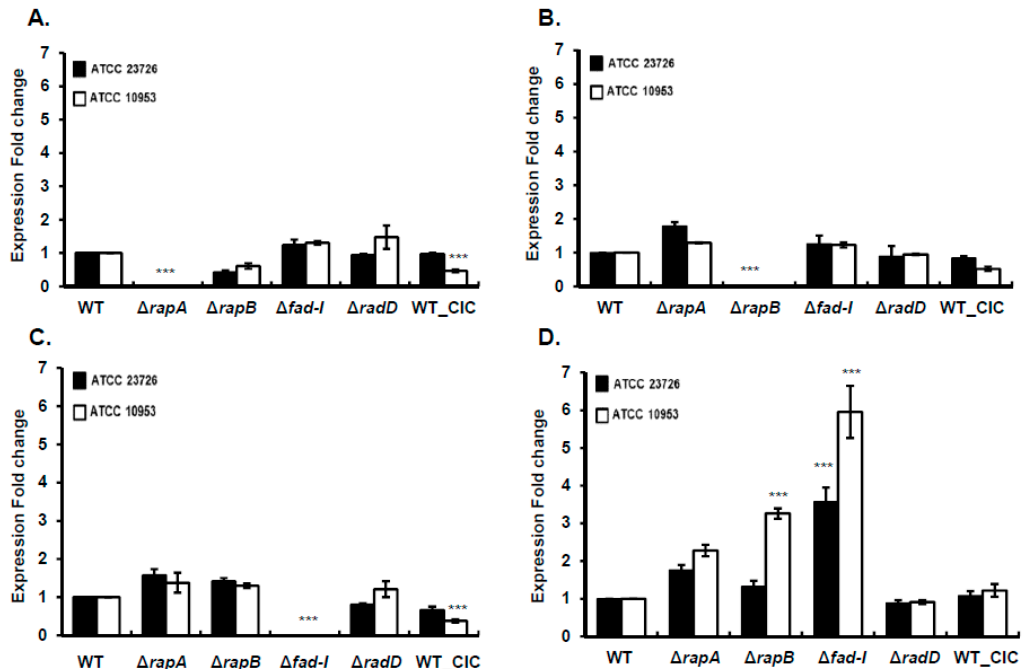
Figure 3. Transcriptional analysis of radD -operon genes in wild-type F. nucleatum ssp. nucleatum (ATCC 23726) and F. nucleatum ssp. polymorphum (ATCC 10953) and their mutant derivatives. Expression fold changes compared to wild-type are shown for ( A ) rapA , ( B ) rapB , ( C ) fad-I , and ( D ) radD for mutant derivatives and the WT_CIC control strains. Data are presented as the mean and standard error of mean of three independent experiments. (*** represents p ≤ 0.001 compared to the wild-type control).